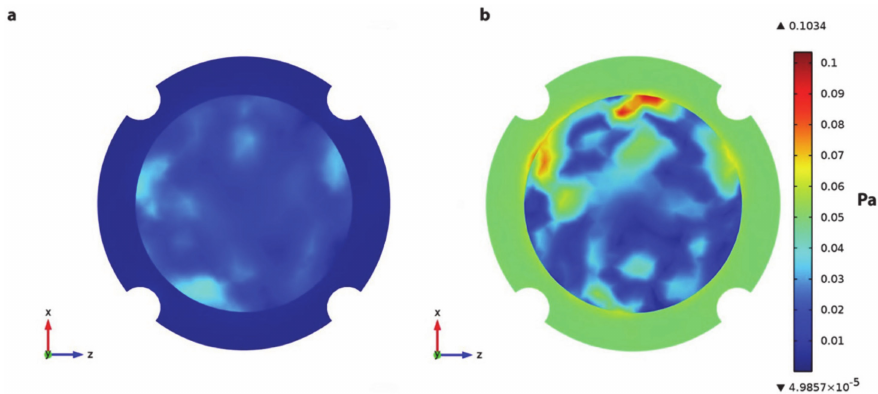
Figure 7. Comparison of von Mises stress map experienced by hMSCs on nanohydroxyapatite (HA) / *PCL ( a ) and *PCL ( b ) sca ff olds in the TM bioreactor during the culture at 1.0 s from the start position (t = 0 s).